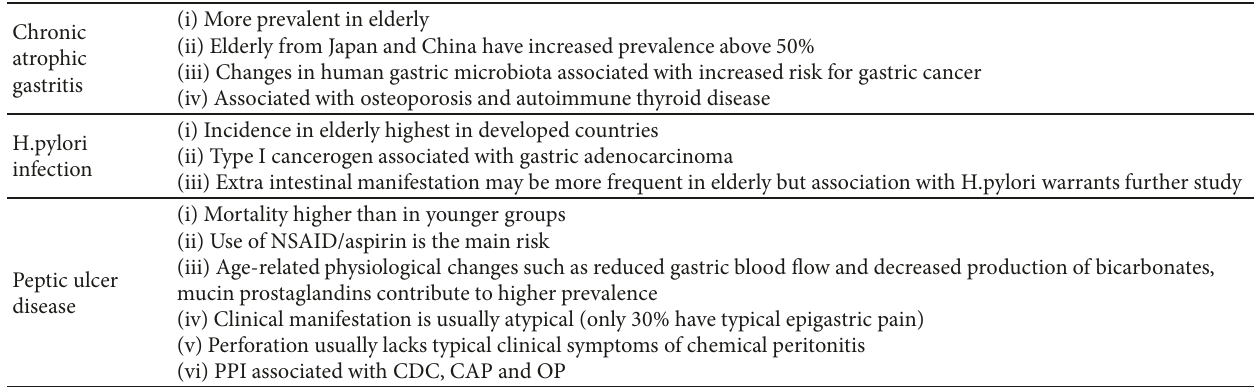
Table 3: Gastric disease characteristics in older